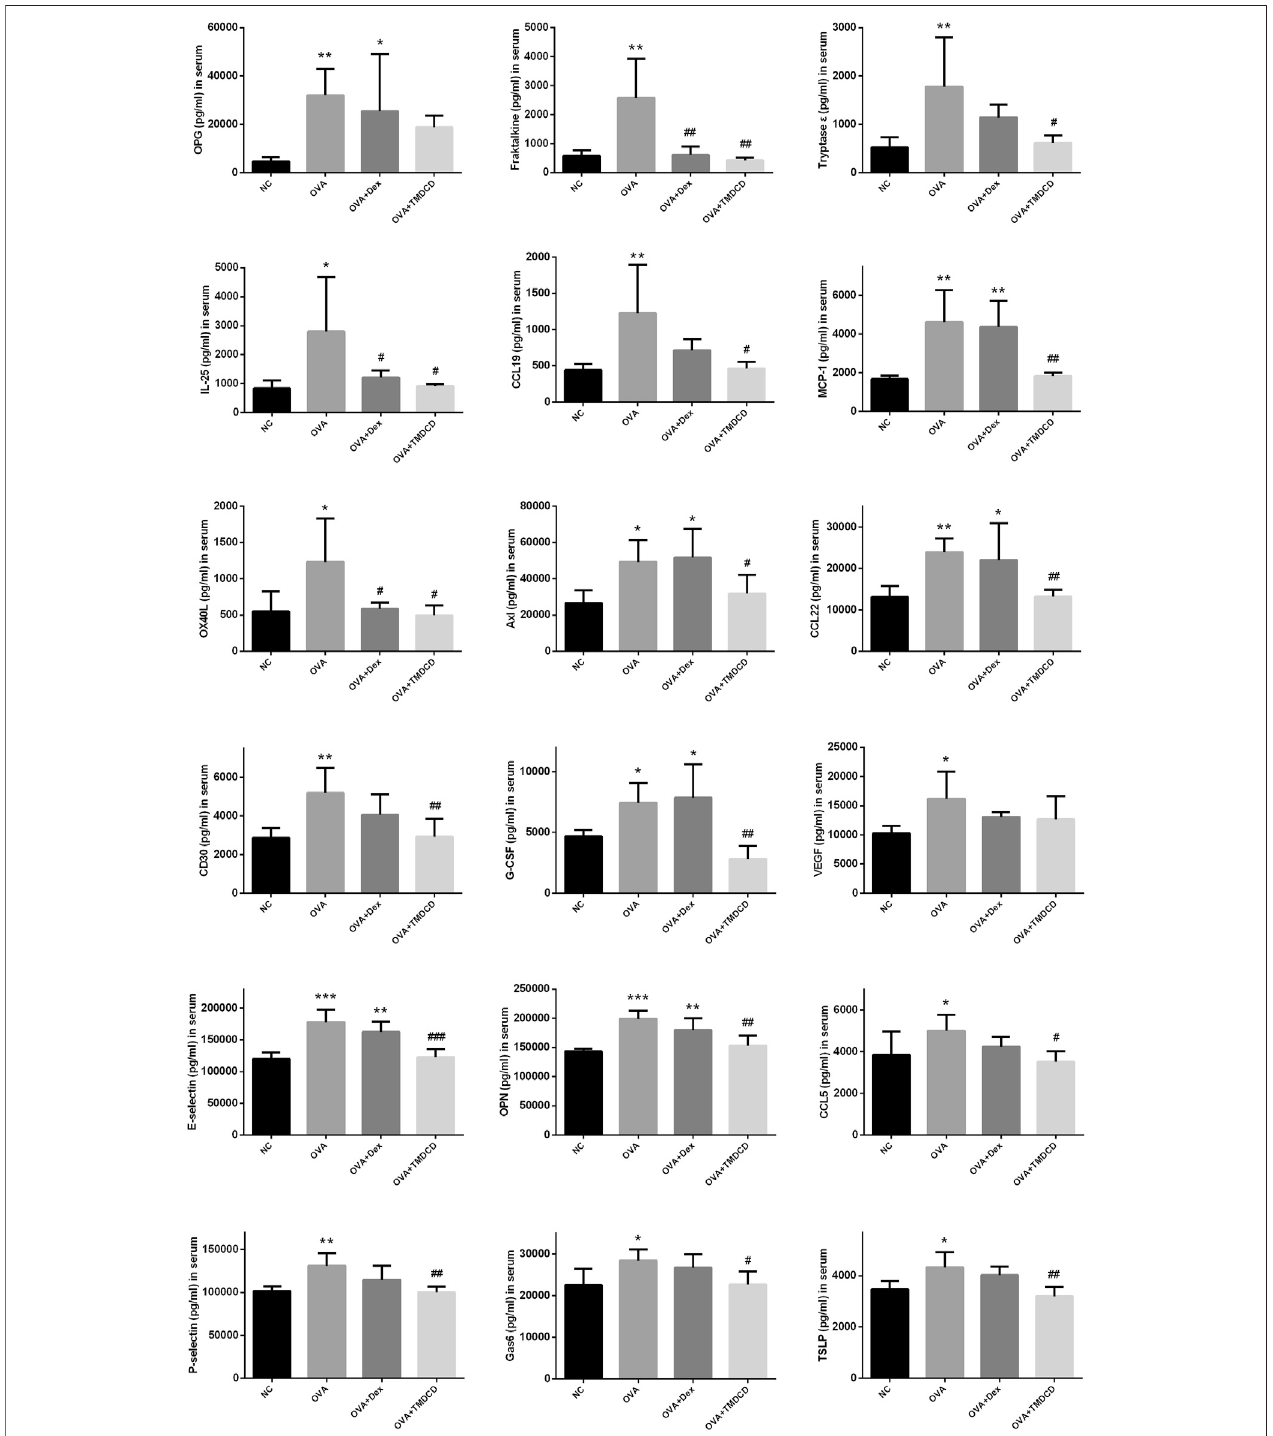
FIGURE6| TheregulationofTMDCD onserum differential expressed proteins. Theresults wereexpressed asMean ± SEM. Compared with NC group, * p < 0.05, ** p < 0.01, *** p < 0.001, compared with OVA group, # p < 0.5, ## p < 0.01, ### p < 0.001 ( n (cid:2) 4 – 5 mice/group).